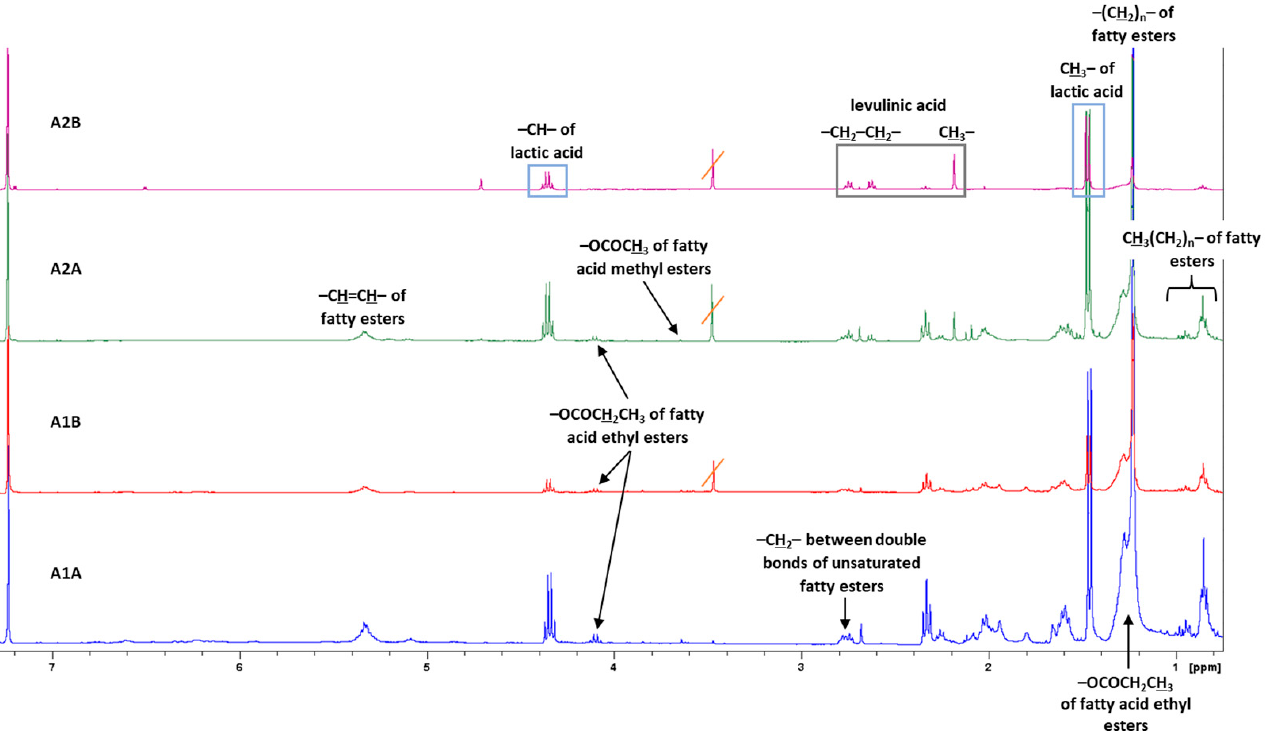
Figure 2. 1 H-NMR spectra (CD 3 OD, 400 MHz) of the fractions AE, AG, and AI. 3.3. LC-MS/MS Analysis of n-Butanol Extract of Dioscorea communis Berry Juice The n -butanol extract (A3) of the berry juice obtained after liquid-liquid extraction (Section 2.3) was submitted to LC-MS/MS analysis. The putative identification of these compounds is summarized in Table 8, where the compounds are listed according to their retention times in the total ion chromatogram (TIC) (Figures S34 and S37). Its 1 H-NMR spectrum was also measured (Figure S33). Based on these results, the main constituent of A3 was lactic acid. Moreover, more than 45 compounds were tentatively identified by LC- MS analysis, including amino acids, organic acids, sugars, fatty acid derivatives, N - containing derivatives, flavonoids, phenolic acids, and other phenolic derivatives. The molecular formulas were established based on high-precision quasi-molecular ions such as [M-H] - , [M+CH 3 COO] − , [M+HCOO] − , [M+H] + , or [M+Na] + with a mass error of 5.0 ppm,